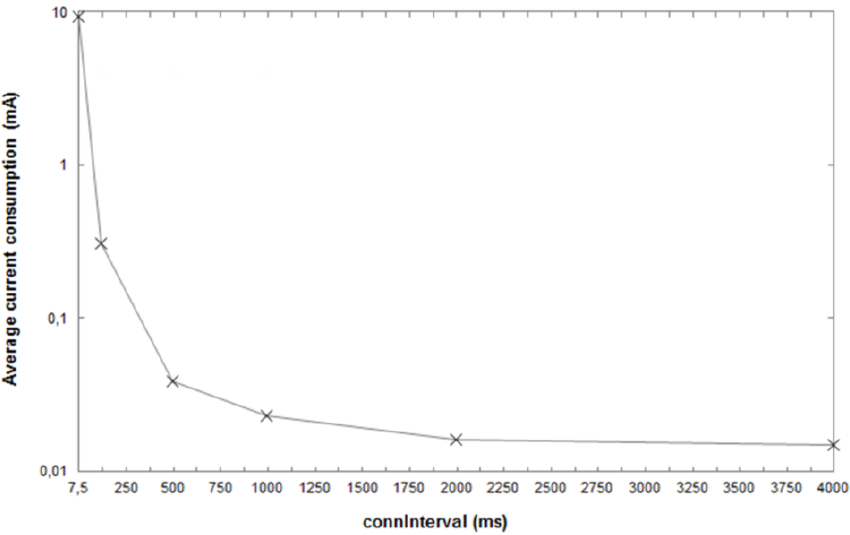
Figure 18. Average current consumption, per variation of connInterval , measured in a CC2540 slave . The operating voltage of this IC is 3 V. It is a one-way communication with connSlaveLatenxy = 0. The Texas Instruments BLE module CC2540 [83] has a USB interface that implies a more relevant drawn current compared to I2C or SPI interfaces (e.g., the CC2541 [77] module has an I2C interface). A BLE module with a USB interface could be a good reference for a central node rather than a peripheral one. Adapted from